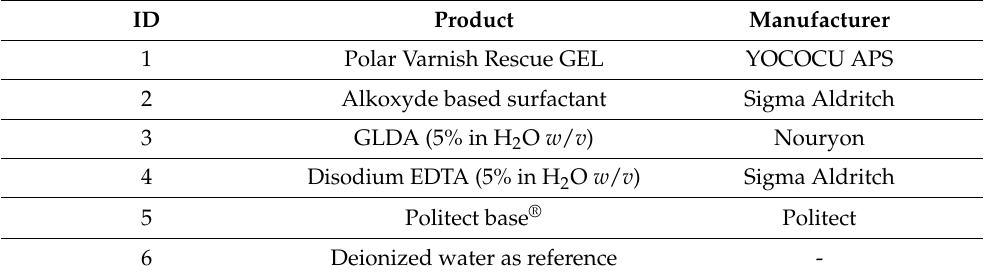
Table 2. Tested cleaning